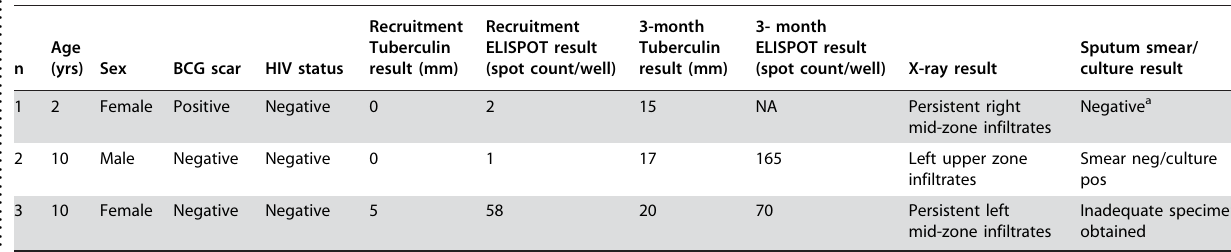
Table 3. Details of tuberculin ‘converters’ who were diagnosed as secondary cases. .. ... .... ... ... .... ... ... .... ... ... .... ... ... .... ... ... .... ... ... .... ... ... .... ... ... .... ... ... .... ... ... .... ... ... .... ... ... .... ... ... .... ... ...